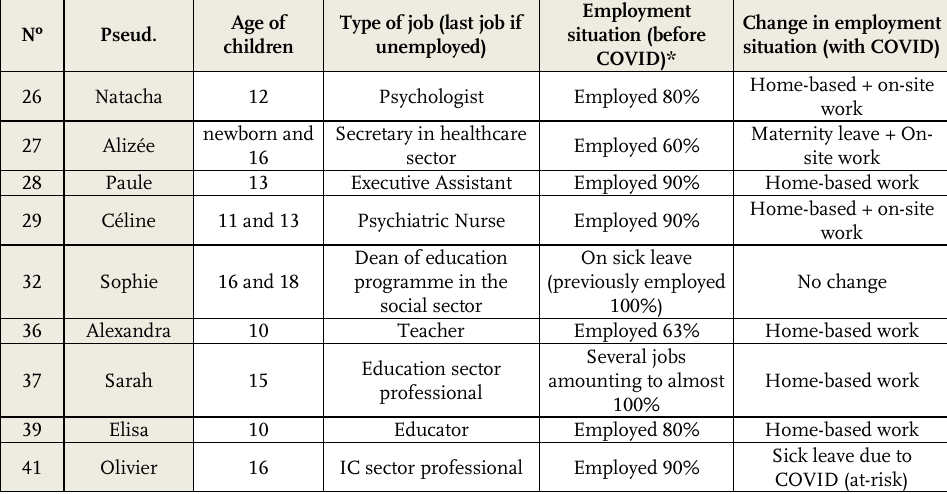
Table A.1 : Sample characteristics and changes in main life domains triggered by the pandemic